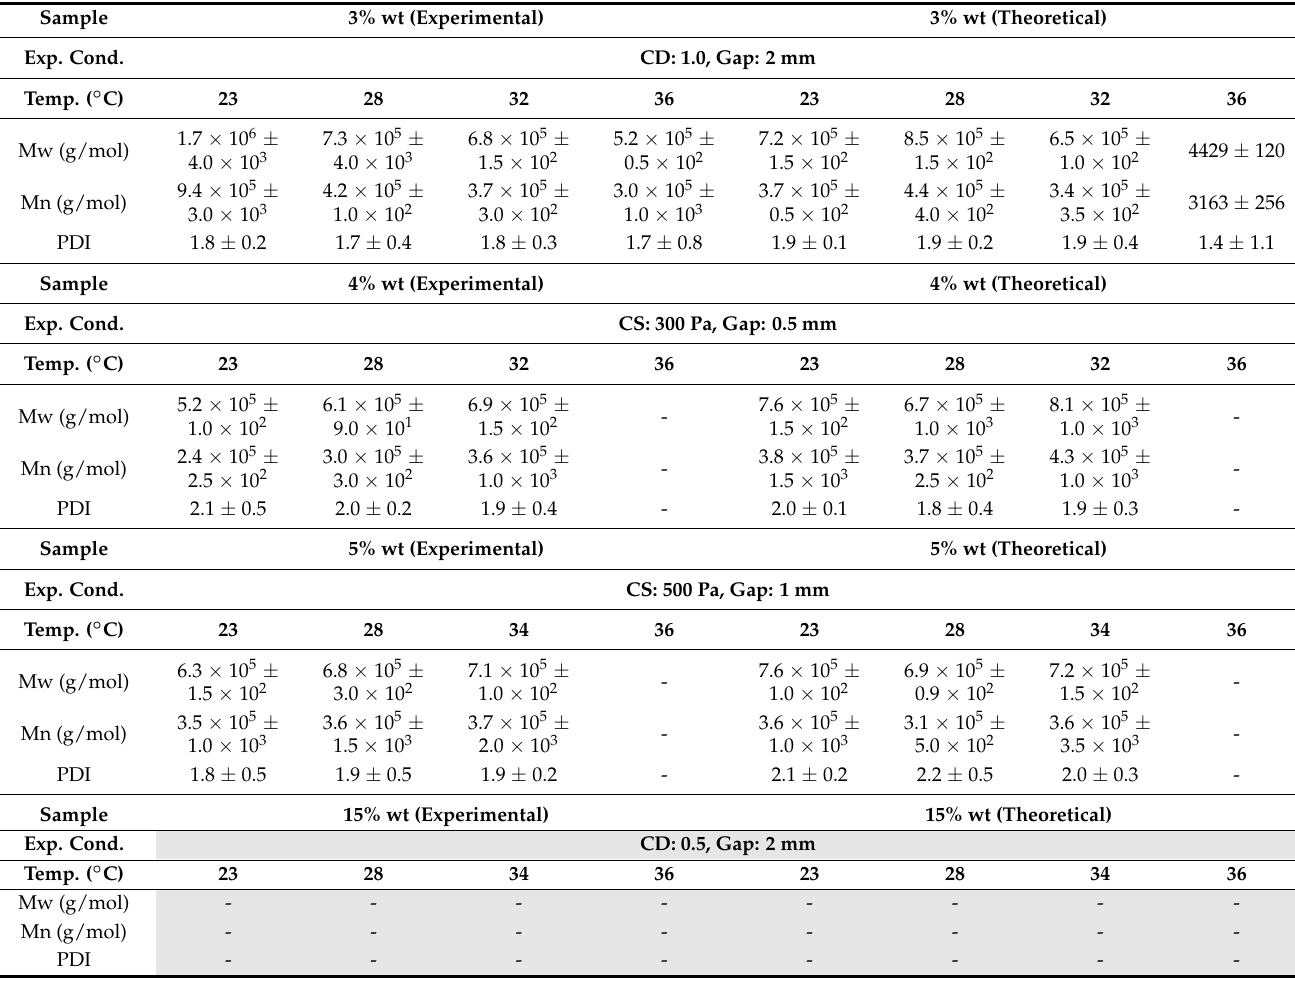
molecular weight. e Number average molecular weight. f Polydispersity